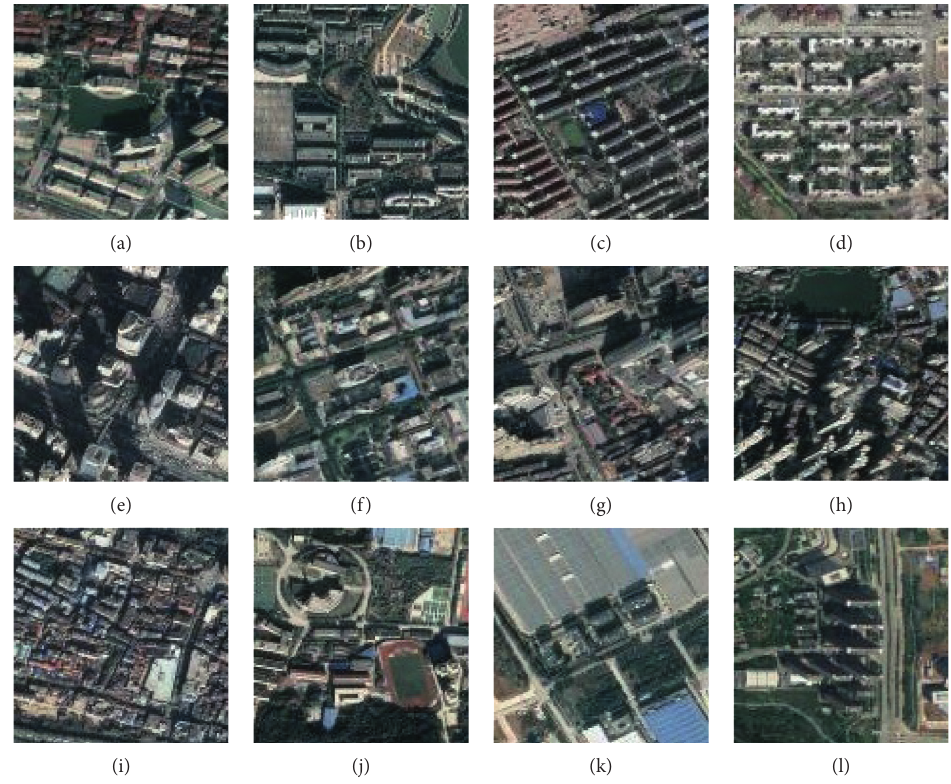
Figure 4: Three types of typical areas in Wuhan: typical OL areas include (a) Wuhan Ship Vocational and Technical College (OL � 0.8707), (b) Jianghan University College of Arts and Sciences (OL � 0.9654), (c) Jin He Yuan (OL � 0.9530), and (d) the Oriental Garden (0.9966). Typical OW areas include (e) Lingxiuzhongnan (OW � 0.7433), (f) Shangheju (OW � 0.5106), (g) Hubei Post Apartments (OW � 0.8717), and (h) the Geological Yard (OW � 0.8607). Typical WL areas include (i) the Hubu Lane Community (WL � 0.6642), (j) Wuhan Institute of Engineering Science and Technology (WL � 0.6568), (k) Meidi Employee Living Quarters (WL � 0.7034), and (l) Guoyao Apartments (WL �